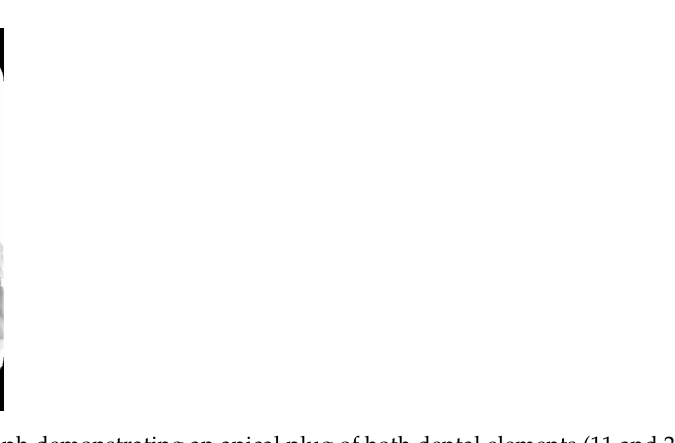
Figure 4. Periapical radiograph demonstrating an apical plug of both dental elements (11 and 21) obtained with MTA.